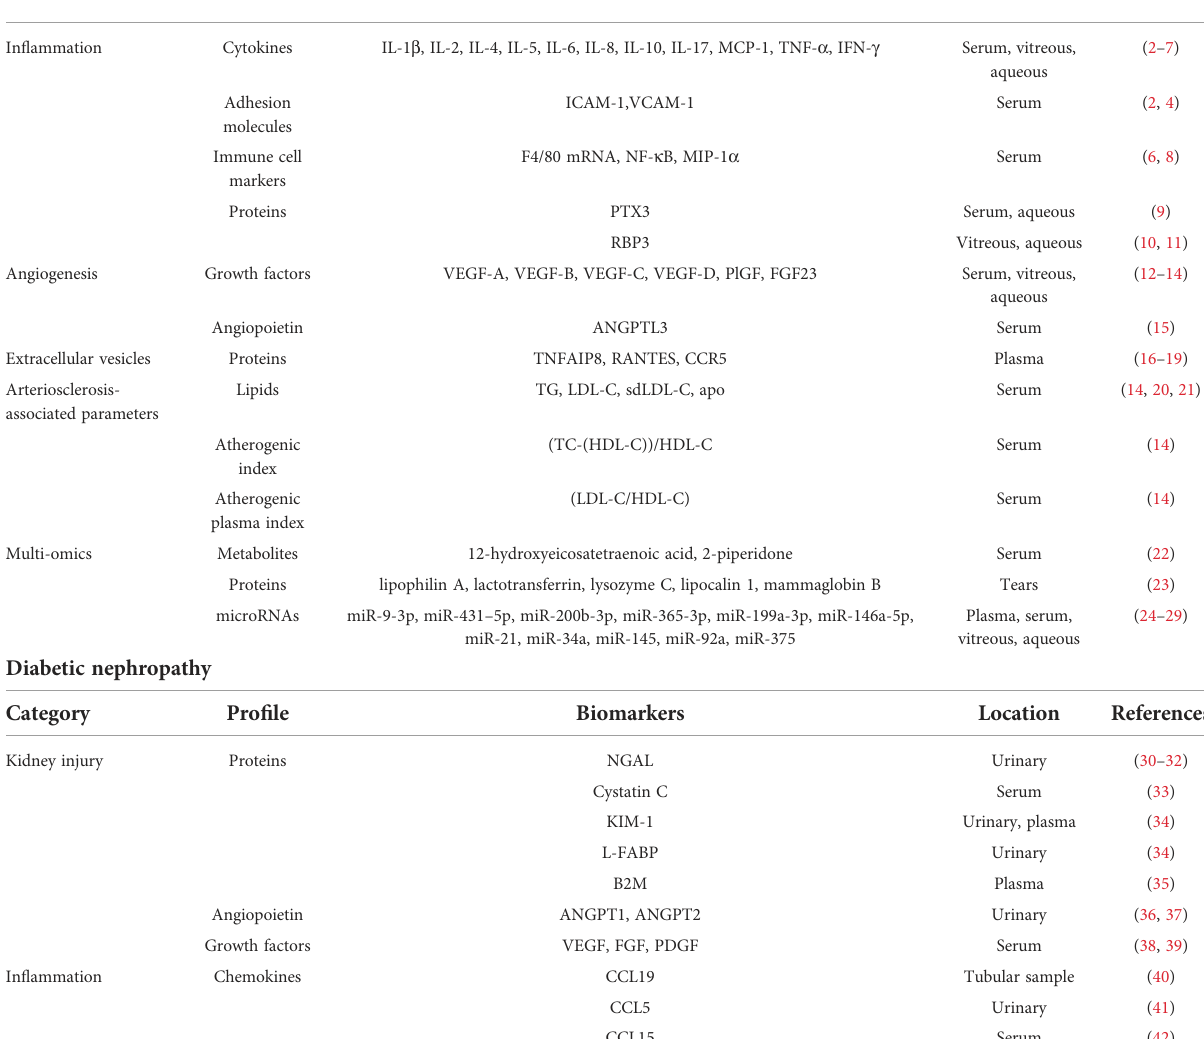
TABLE 1 Biomarkers for DR and